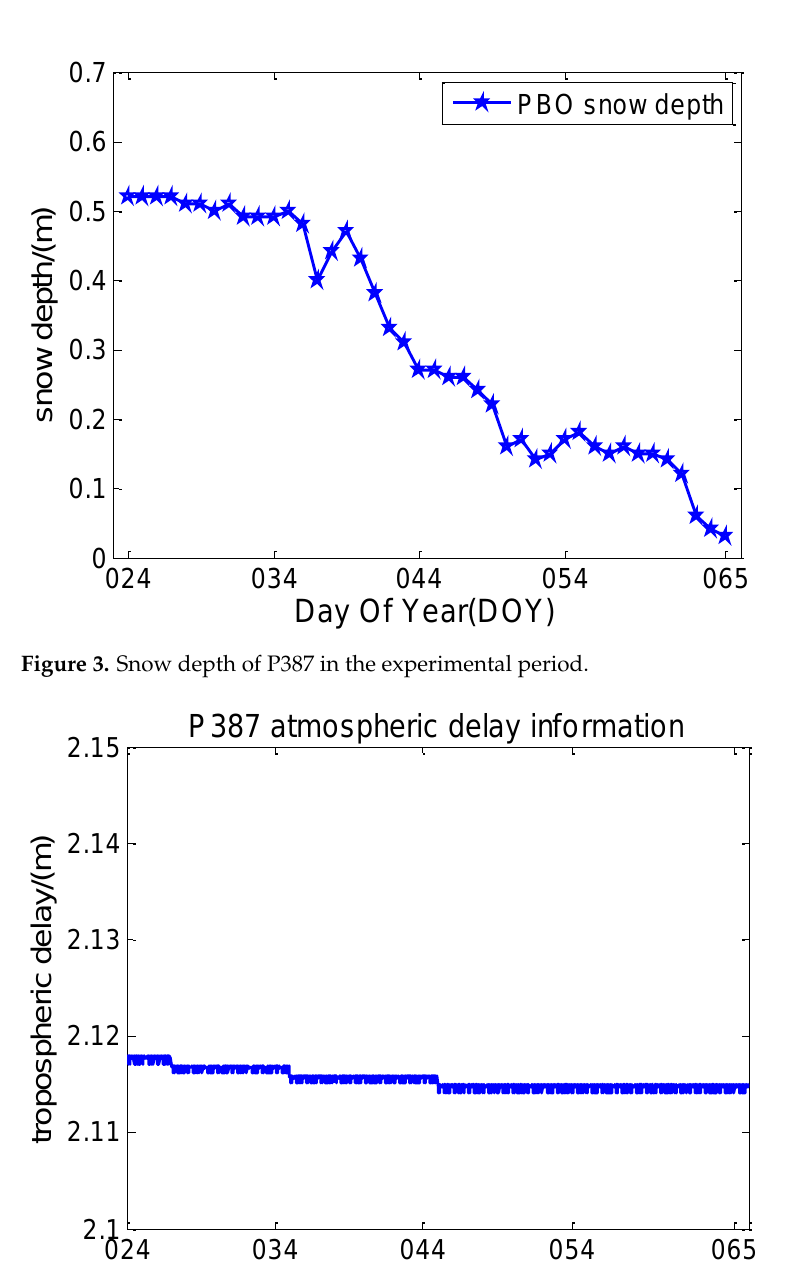
Figure 4. Atmospheric delay information of P387 station during the experiment.